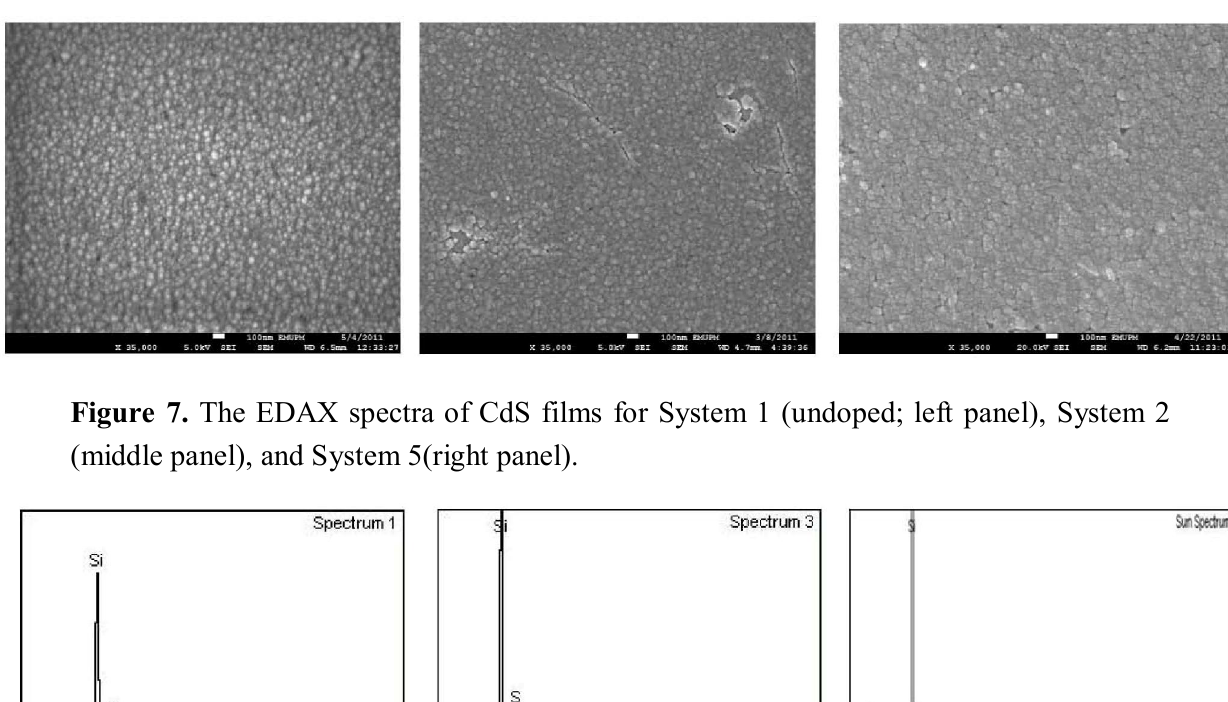
Figure 6. FE-SEM images of CdS films corresponding to System 1 (undoped; left panel), System 2 (middle panel), and System 5 (right).